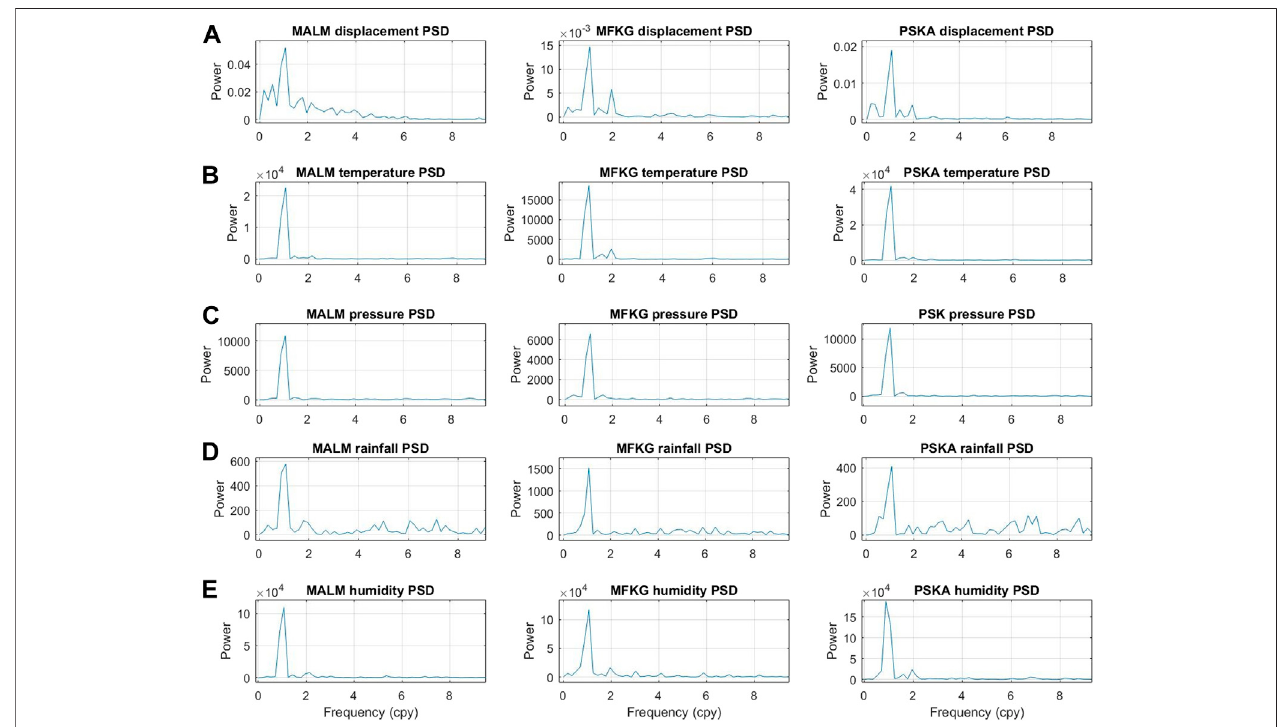
FIGURE 6 | Fourier power spectra. (A) cGPS surface displacement, (B) atmospheric temperature, (C) atmospheric pressure, (D) rainfall, and (E) humidity decomposition spectra. 30.